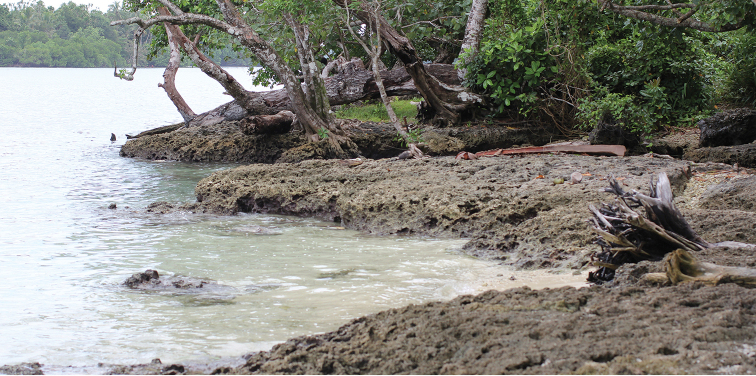
Habitat, Peronia
peronii, Papua New Guinea, Madang, limestone rocky intertidal (st PM 12).